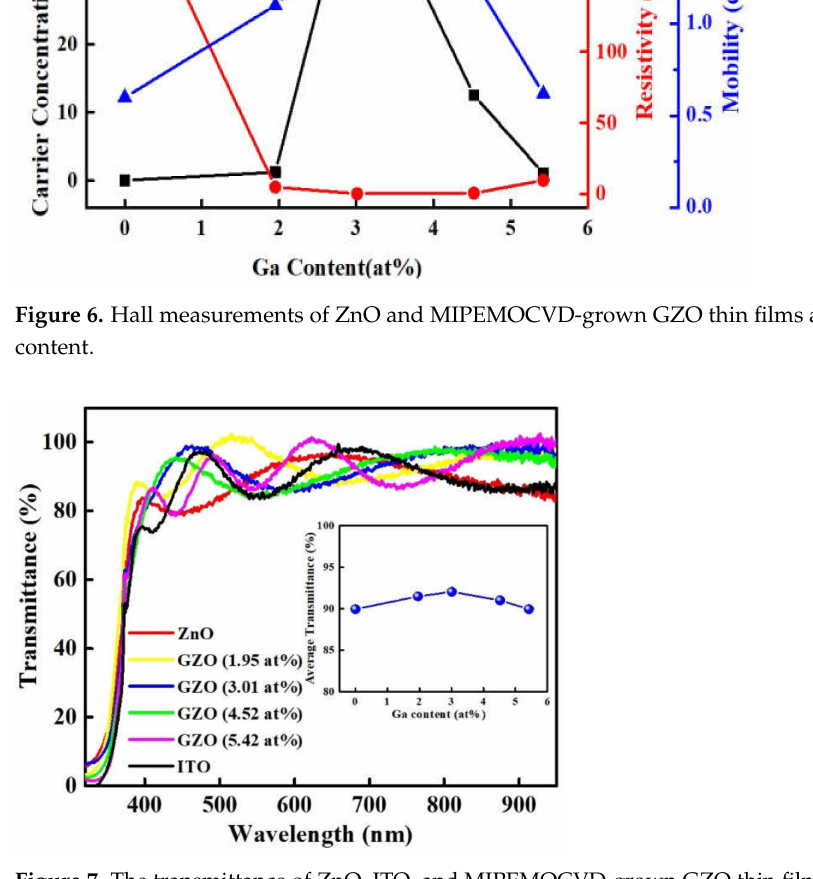
Figure 7. The transmittance of ZnO, ITO, and MIPEMOCVD-grown GZO thin films with varying Ga content over the wavelength range of 300–850 nm and the inset shows the average transmittance over the visible range for MIPEMOCVD-grown GZO thin films with varying Ga